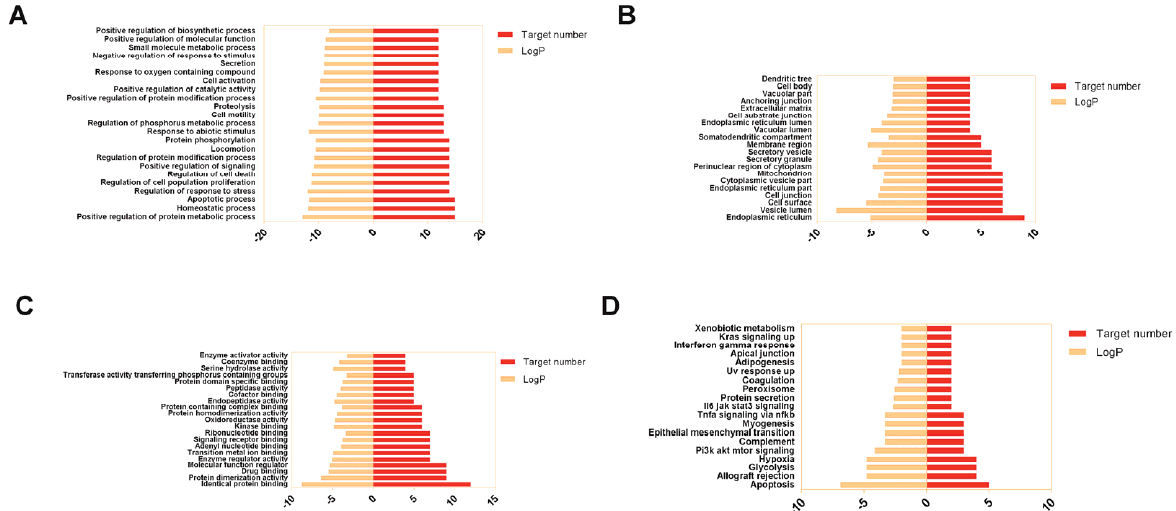
Figure 3. Enrichment analysis of potential targets from active ingredients of LJF against NAFLD. Analysis of Gene Ontology terms for biological process ( A ), cellular component ( B ) and molecular function ( C ); Analysis of KEGG pathways ( D ). Bars colored in dark orange represent the number of targets involved in each entry; Bars colored in light orange represent log p.